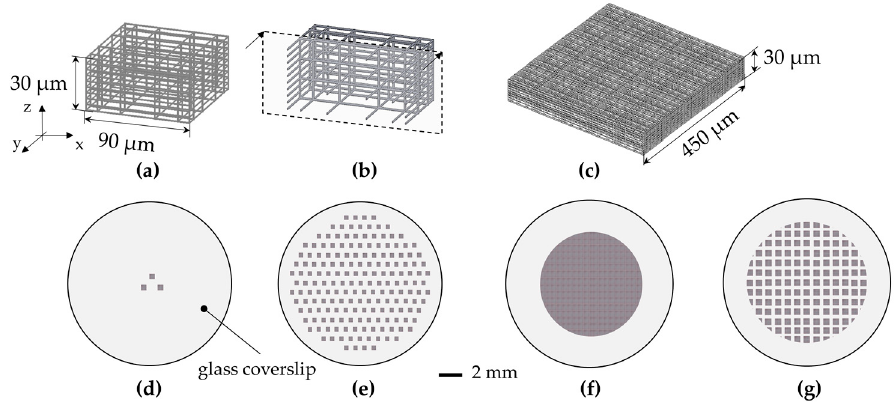
Figure 1. The nichoid culture substrate. ( a ) CAD of the nichoid elementary unit; ( b ) Cross-section of the nichoid; ( c ) CAD of the matrix of nichoids, consisting of 5 × 5 elementary nichoids. Scale-up approach: ( d ) the culture substrate composed of three elementary nichoids; ( e ) The substrate composed of approximately 367 elementary nichoids; ( f ) The culture substrate covered with continuously-packed nichoids (CPN), resulting in 3500 adjacent elementary nichoids; ( g ) The culture substrate covered with a fractionated supermatrix of nichoids (FSN) including 218 matrixes at a distance of 30 µ m.